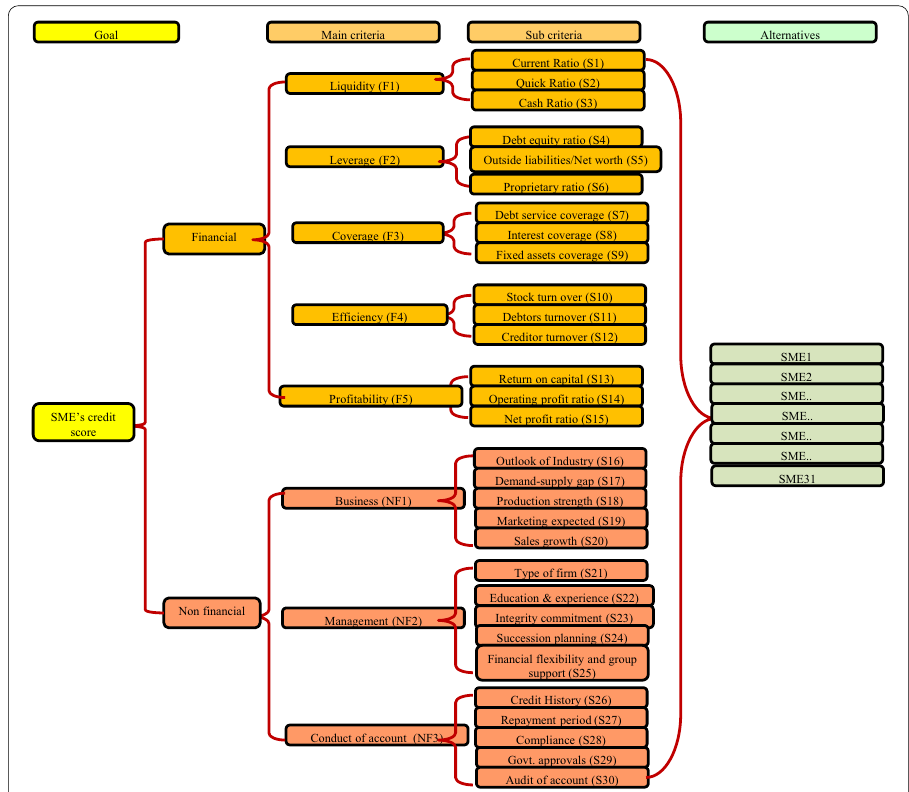
Fig. 2 Decision layers of the model considering criteria, subcriteria, and